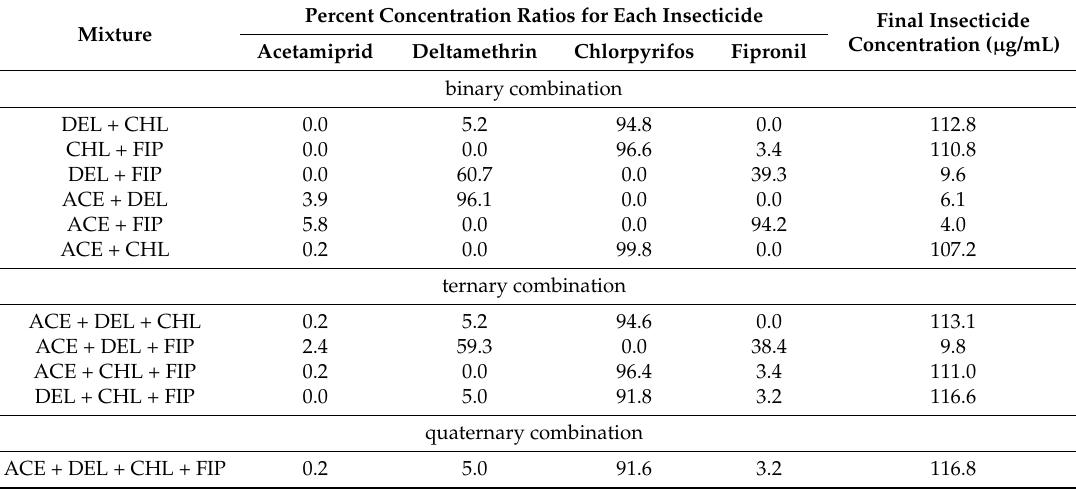
Table 1. The percent concentration ratios (%) of various pesticide compounds in EECR mixtures. The final insecticide concentration in the different mixture is also